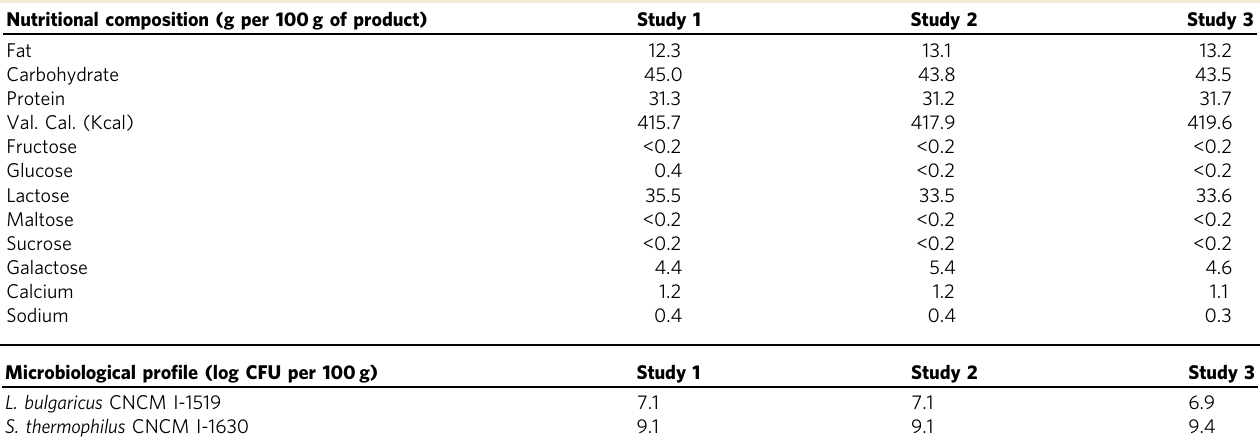
Table 2 Nutritional composition of Y lyophilized